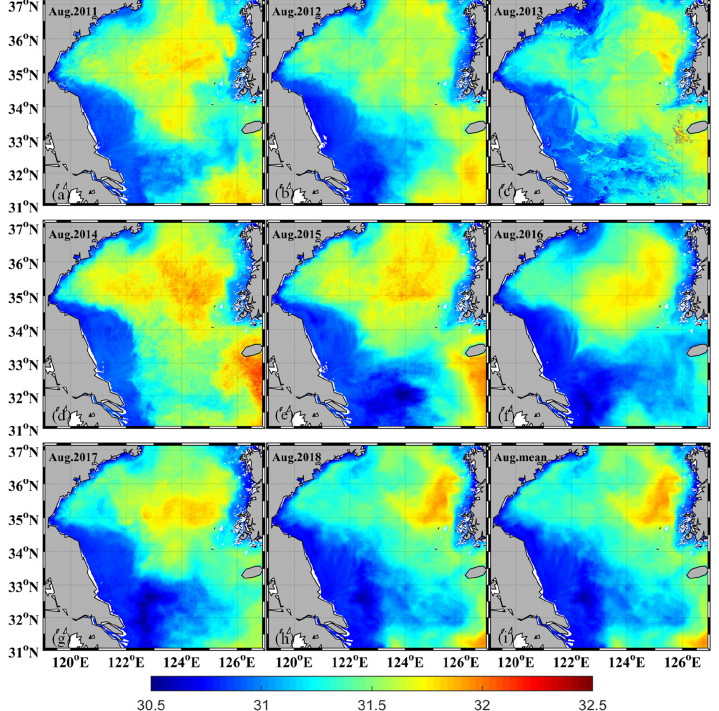
Figure 8. Spatial distribution of SSS derived from GOCI satellite observations ( a – h ) during 2011–2018 in August and ( i ) eight-year SSS average in August.